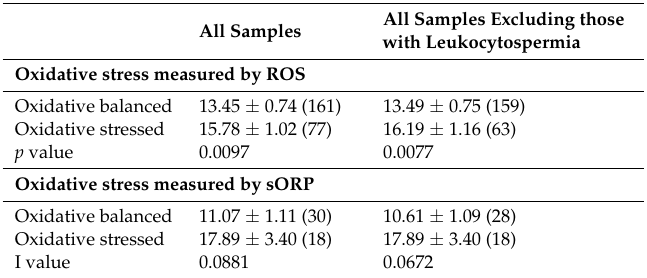
Table 3. High DNA stainability of sperm in the presence and absence of oxidative stress. All Samples